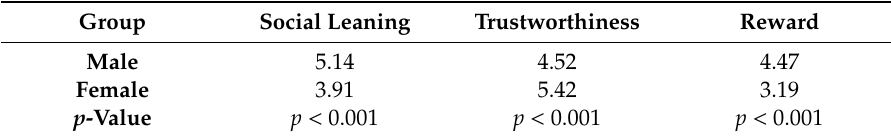
Figure 2. The effect of gender on susceptibility to persuasive strategies (SLEARN = social learning, TRUST = trustworthiness, REWD = reward; horizontal bar indicates the neutral of five on the 1–9 Likert scale). Table 3. Between-group analysis based on gender.